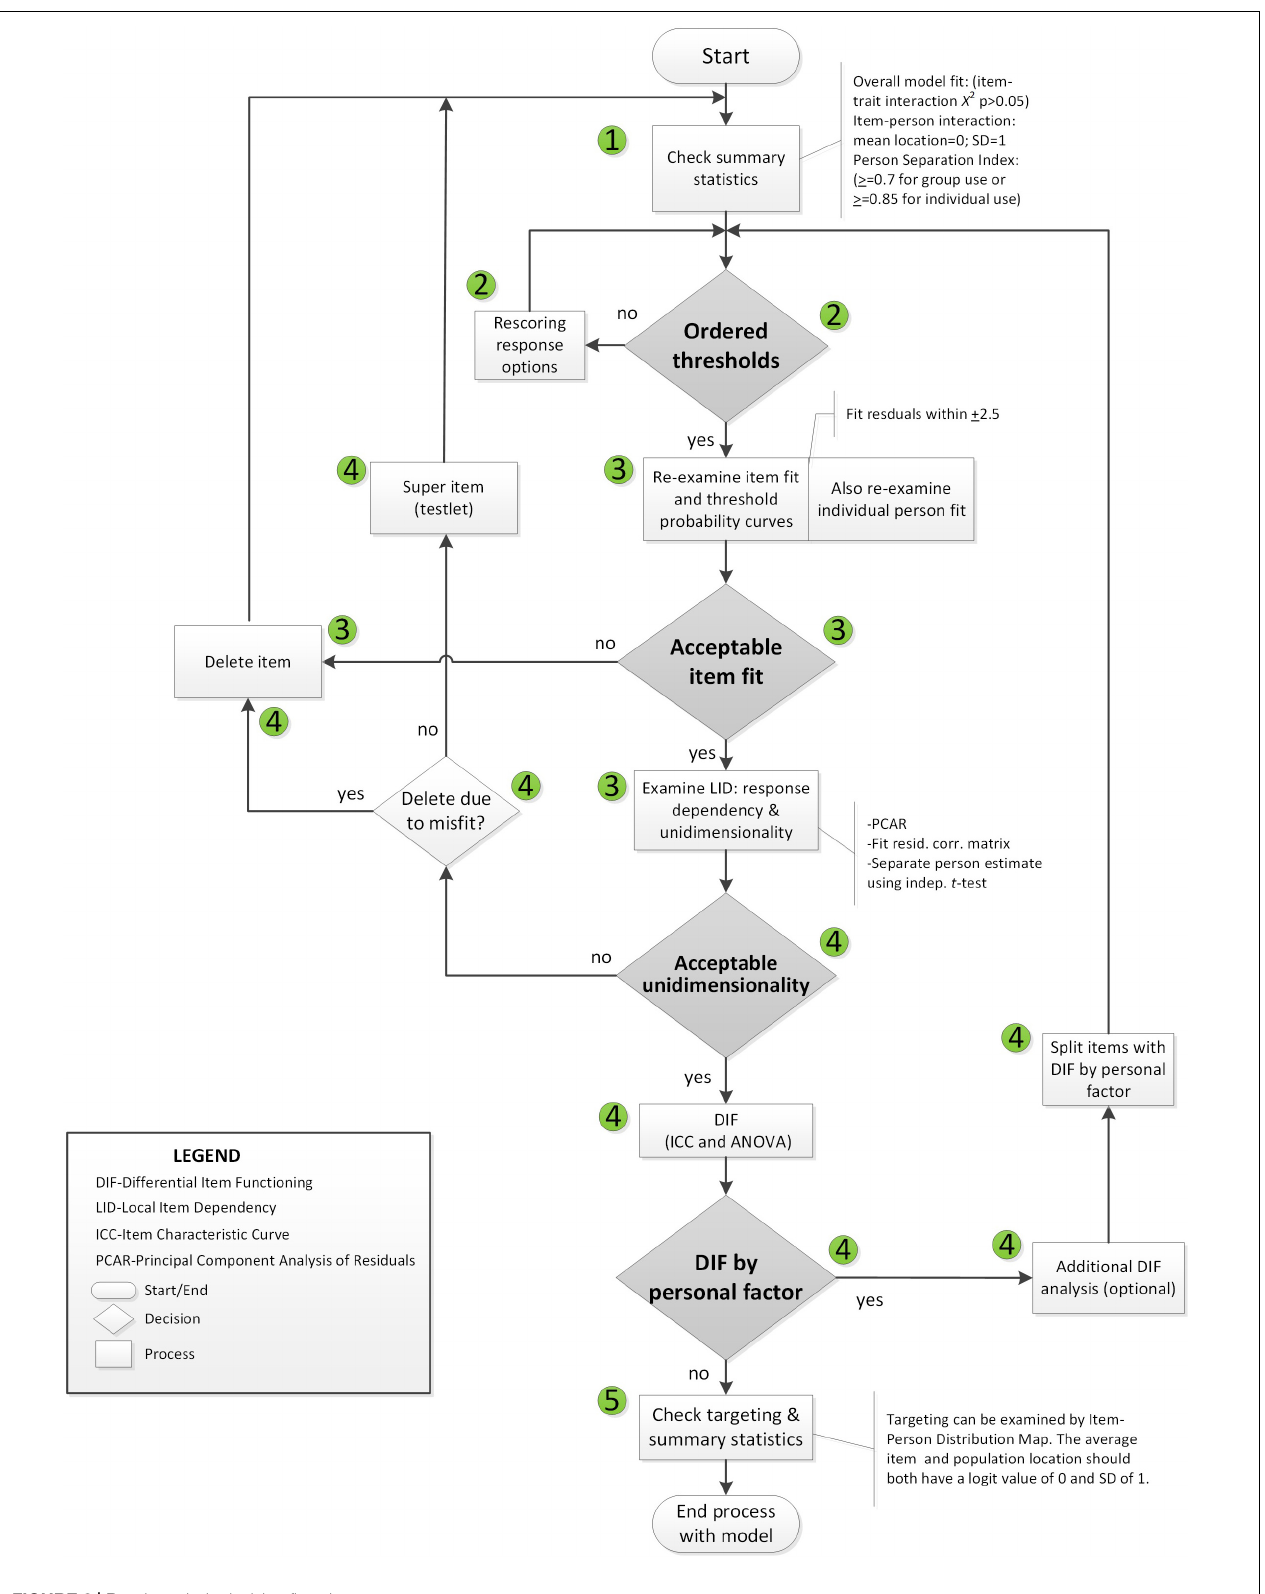
FIGURE 2 | Rasch analysis decision